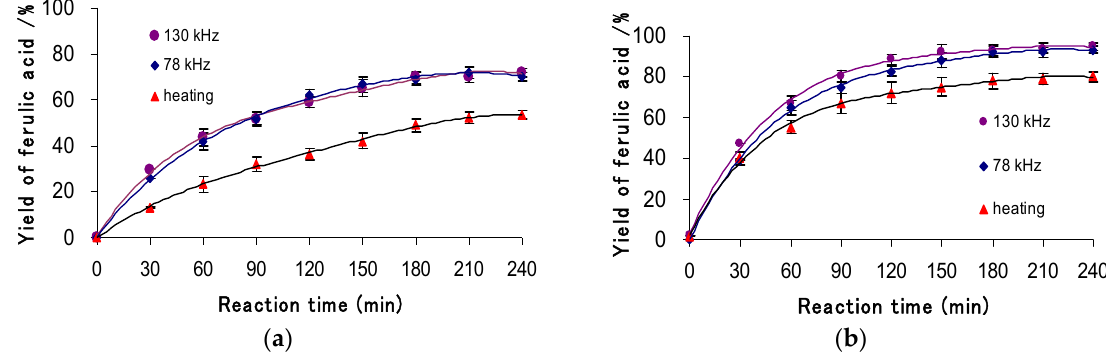
Figure 5. Effect of ultrasonic frequency (kHz) on yield of FA (a ) at temperature of 60 °C; and ( b ) at temperature of 75°C.